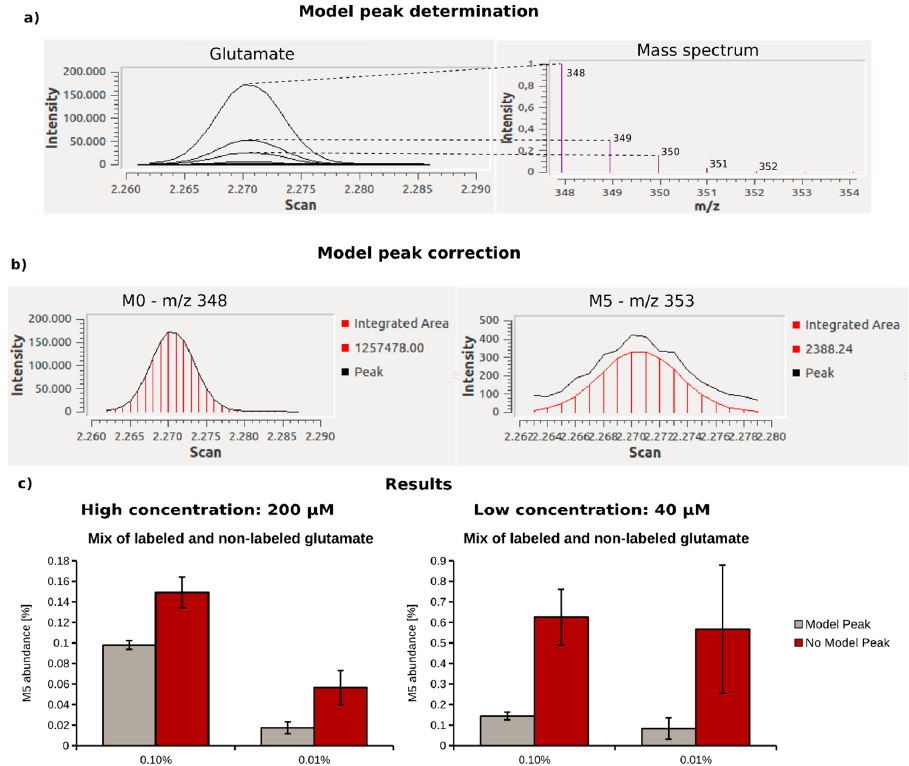
Figure 3. Model peak correction shown for glutamate using MetaboliteDetector—( a ) Gas chromatographic peak and respective mass spectrum of the glutamate MSTFA derivative (Glutamate_3TMS); ( b ) the peak shape of the monoisotopic peak of glutamate (M0— m / z 348) is of high quality, and therefore used for peak shape correction of the low intensity isotopic peaks, like the 5-times labeled derivative (M5— m / z 353); ( c ) comparison of the mass isotopomer distributions (MIDs) for 0.10 and 0.01%. 13 C-enriched glutamate at high (200 µM) and low (40 µM) concentration, calculated with (gray) and without (red) model peak